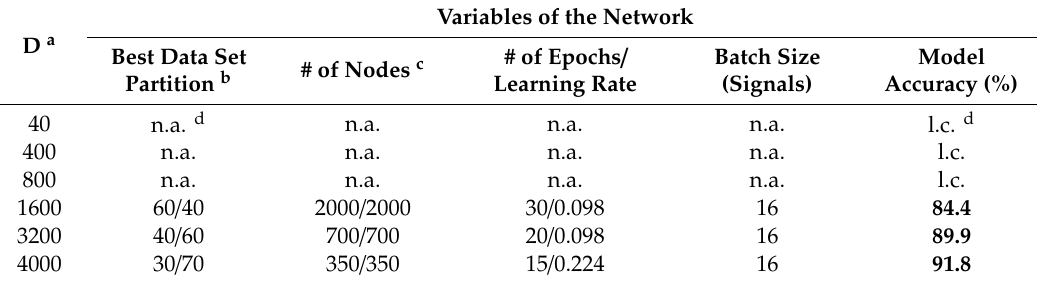
a Data set size, i.e., the number of signals used to feed the network. b Percentage of signals used as training and testing samples (e.g., 60 / 40 = 60% for training and 40% for testing).